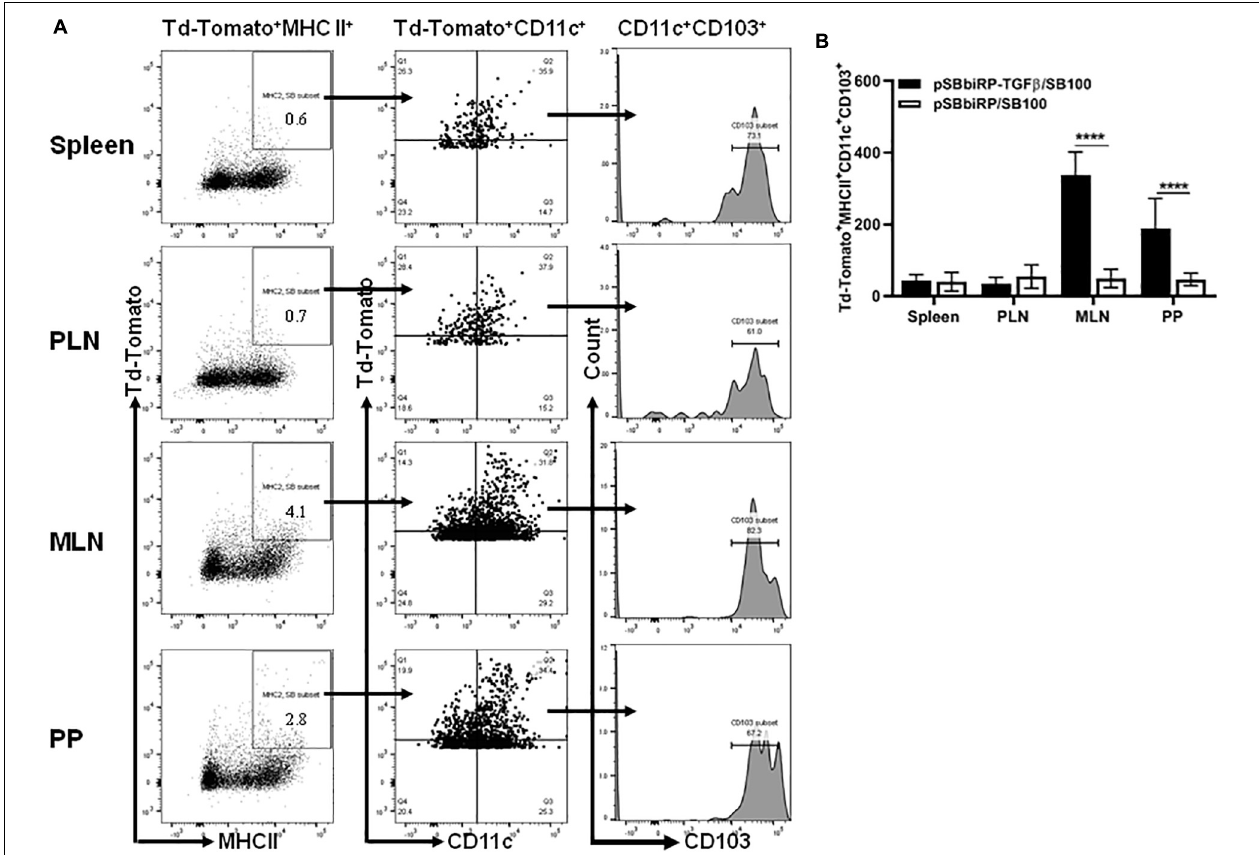
FIGURE 4 | Vaccine-delivered TGF β alters levels of gut DCs. NOD mice were given a single oral dose of Salmonella (pSBbi-RP-TGF β /SB100, n = 10) or Salmonella (pSBbi-RP/SB100, n = 10). Four weeks post-vaccination, red fluorescent protein was detected in DCs of different organs. (A) Representative FACS plots gated the frequency of the live red-labeled MHCII + CD11c + CD103 + cells in the spleens, PLN, MLN, and PP of mice from each group. (B) Quantification of the numbers of MHCII + CD11c + CD103 + in red-labeled cells in the spleen, PLN, MLN, and PP. The data shown are the average with SD from two independent experiments. Statistical analysis using two-way ANOVA shows significance between Salmonella (pSBbi-RP-TGF β /SB100) and Salmonella (pSBbi-RP/SB100) groups (**** p <